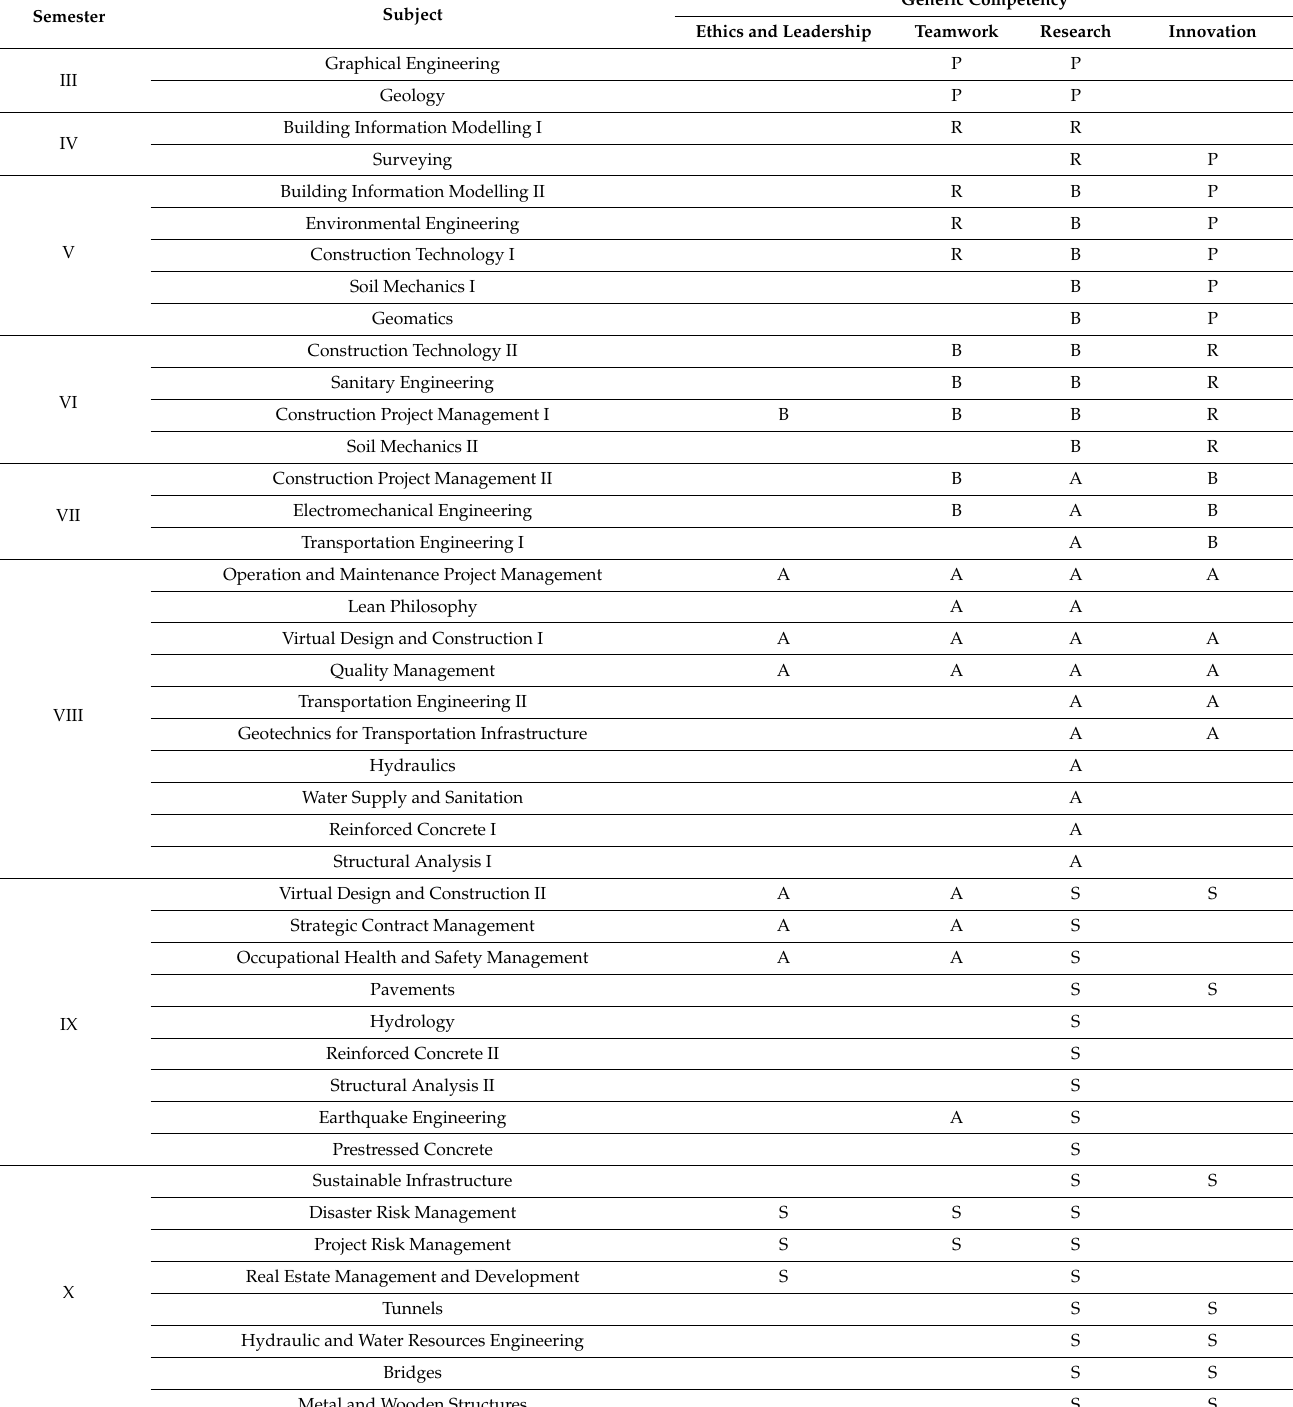
Table 10. Interrelationship matrix with proficiency levels between subjects and generic competencies from the civil engineering program 2